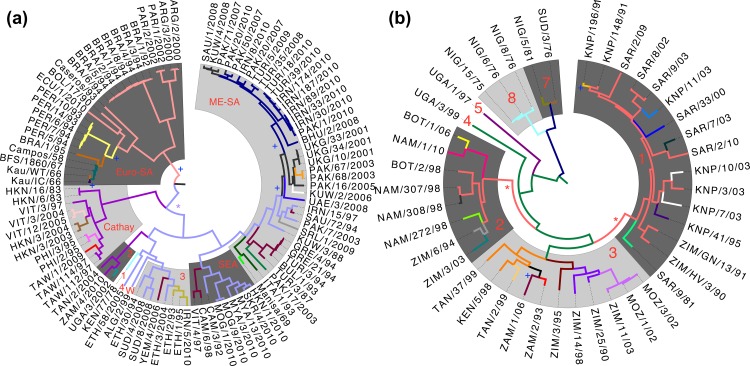
Antigenic evolution of Serotypes O and SAT1.Phylogeny of all serotype O viruses (a) and serotype SAT1 (b) are shown with shading and labelling of topotypes as Fig 1A–1B. Different branch colours denote antigenic dissimilarity with respect to VNT between the viruses derived from analyses of the sequence and serological data and ancestral state reconstruction. Conversely, the same colours in the same phylogeny denote the same antigenic phenotype. +Change in antigenic phenotype for which no causative substitution has been identified. The broadest such group defined by VNT is starred for serotype O (spanning 5 topotypes) and SAT1 (spanning 2 topotypes). As in Fig 1, phylogenies are time-resolved, with branch lengths measured in evolutionary time rather than substitutions.